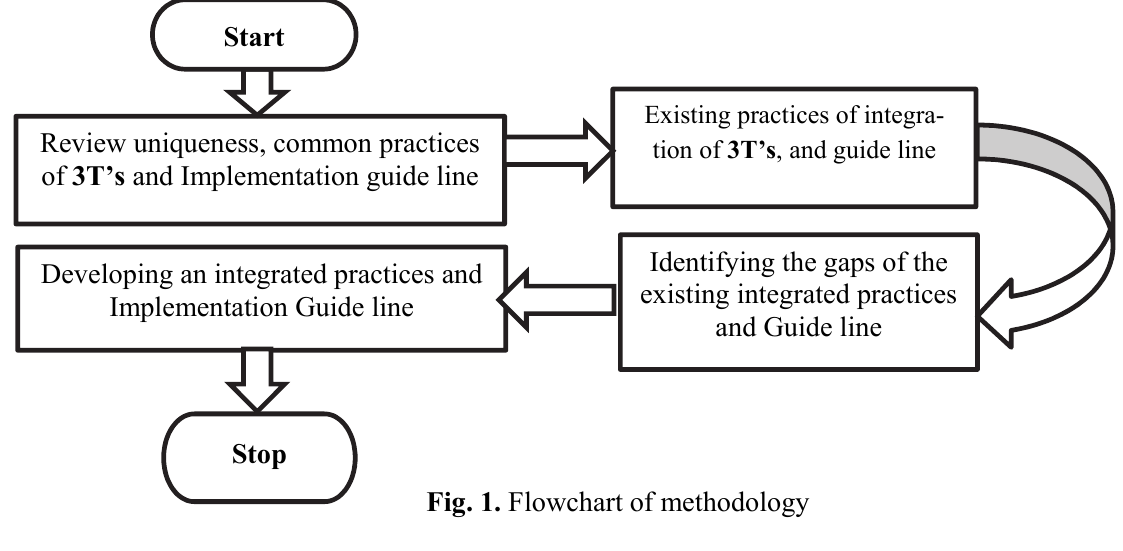
Fig. 1. Flowchart of